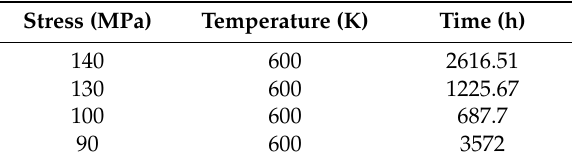
Table 1. Creep testing data of T90 1